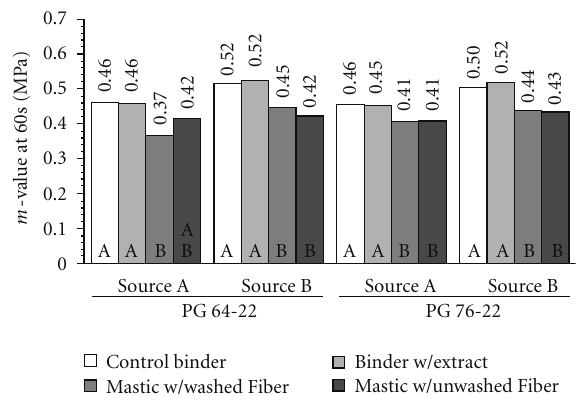
Figure 6: m -value results from the bending beam rheometer (BBR). The test temperature was − 12 ◦ C for all binders.